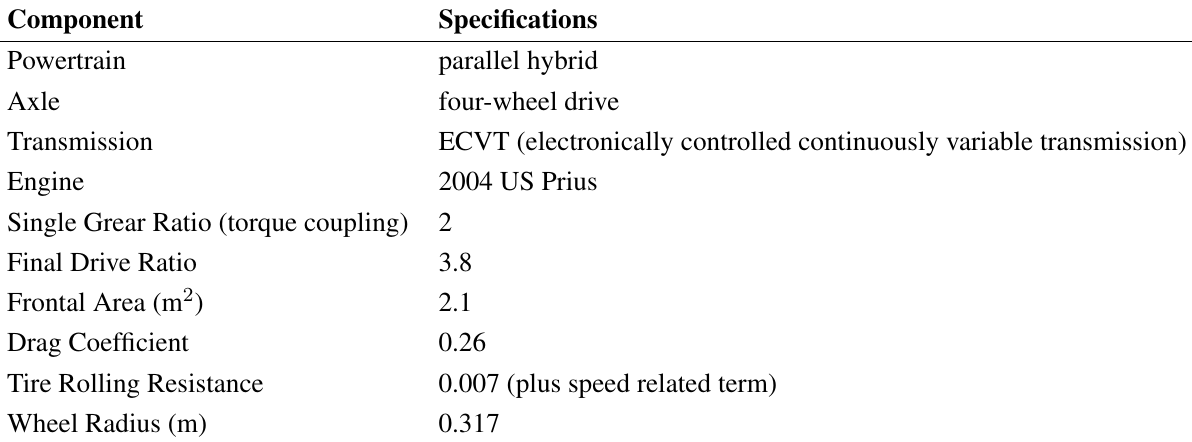
Table 3. Hybrid vehicle